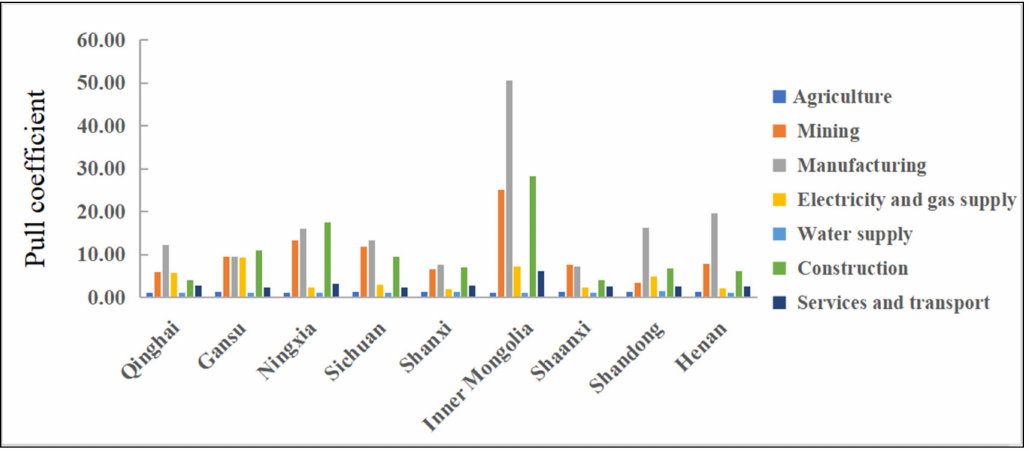
Figure 5. Pull Coefficient of different industrial sectors in different